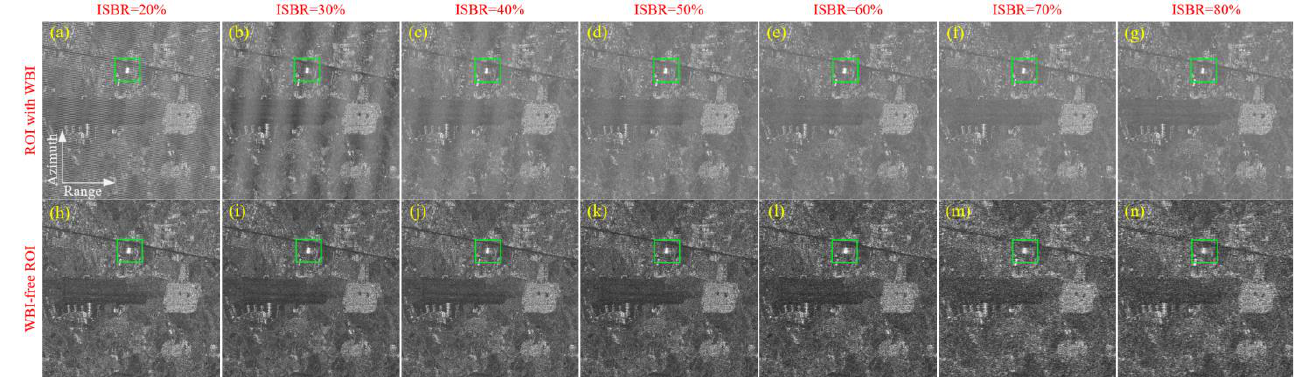
Figure 8. ROIs in Figure 7a – n with green boxes. ( a – n ) Strong point targets with green boxes.